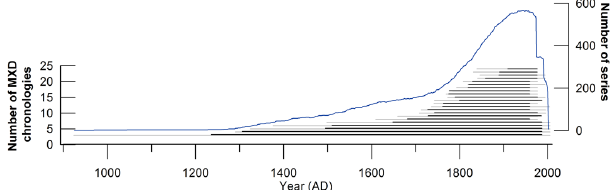
Fig. 2. Total time span (grey line) and reliable time span (black line) after truncation of the 22 MXD chronologies when less than five series were available. Blue line represents total number of MXD